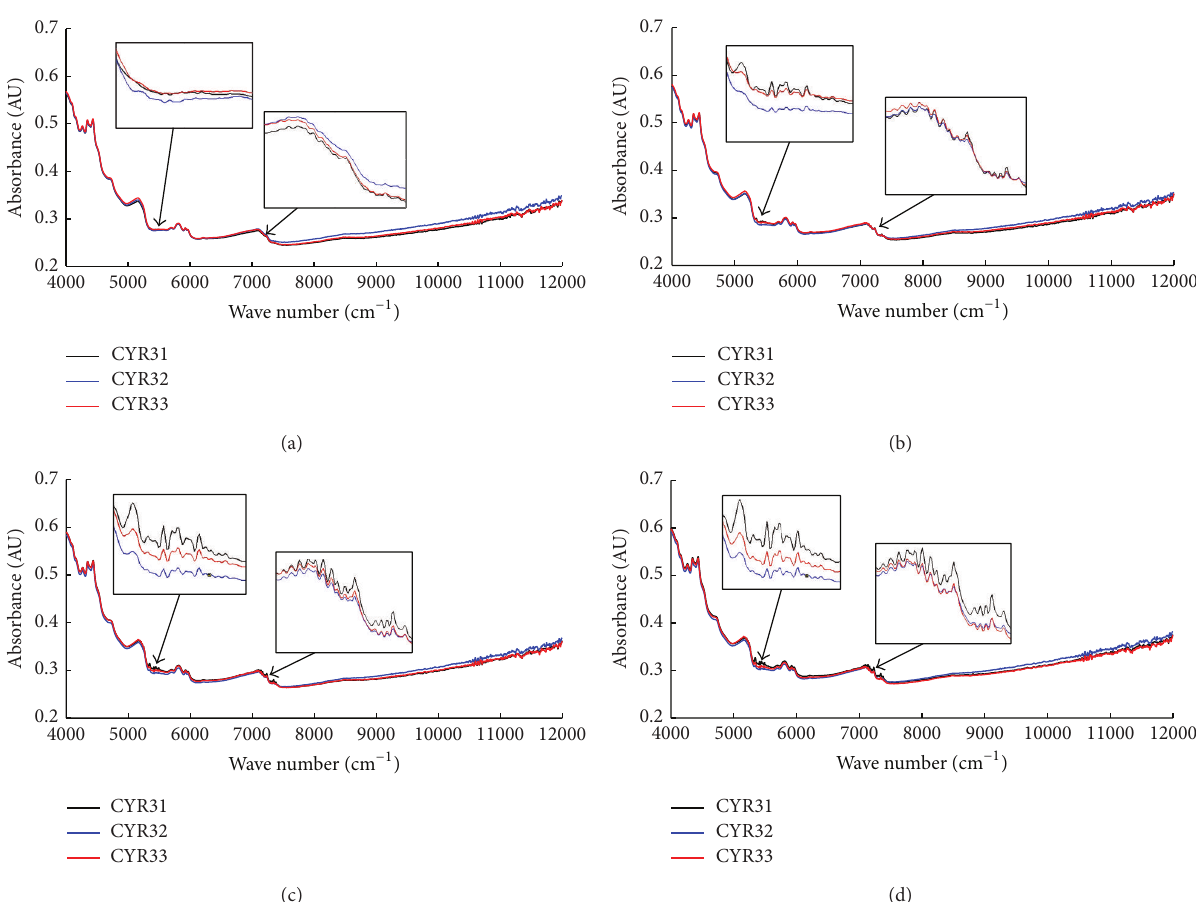
Figure 2: Spectral curves of the three physiological races of wheat stripe rust pathogen under each UV-B intensity exposure. (a) UV-B intensity was 0 𝜇 w/cm 2 , (b) UV-B intensity was 150 𝜇 w/cm 2 , (c) UV-B intensity was 200 𝜇 w/cm 2 , and (d) UV-B intensity was 250 𝜇 w/cm 2 . The spectral ranges of enlarged section in the diagram were 5300–5600 cm −1 and 7000–7400 cm −1 ,